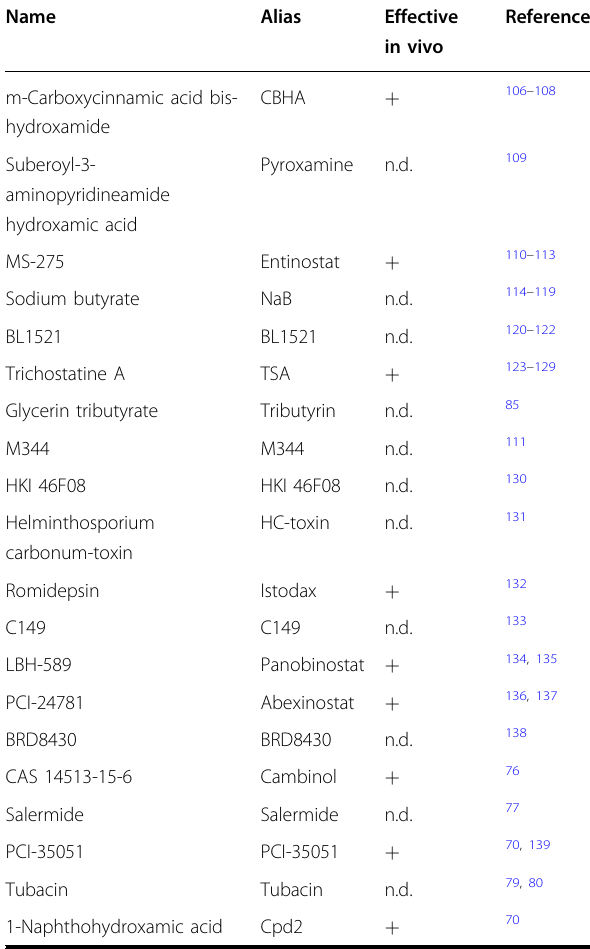
Table 1 HDAC inhibitors studied in